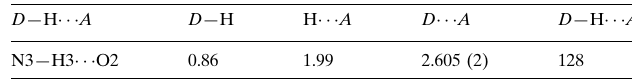
Hydrogen-bond geometry (A˚ , (cid:2) ). D —H (cid:1)(cid:1)(cid:1) A